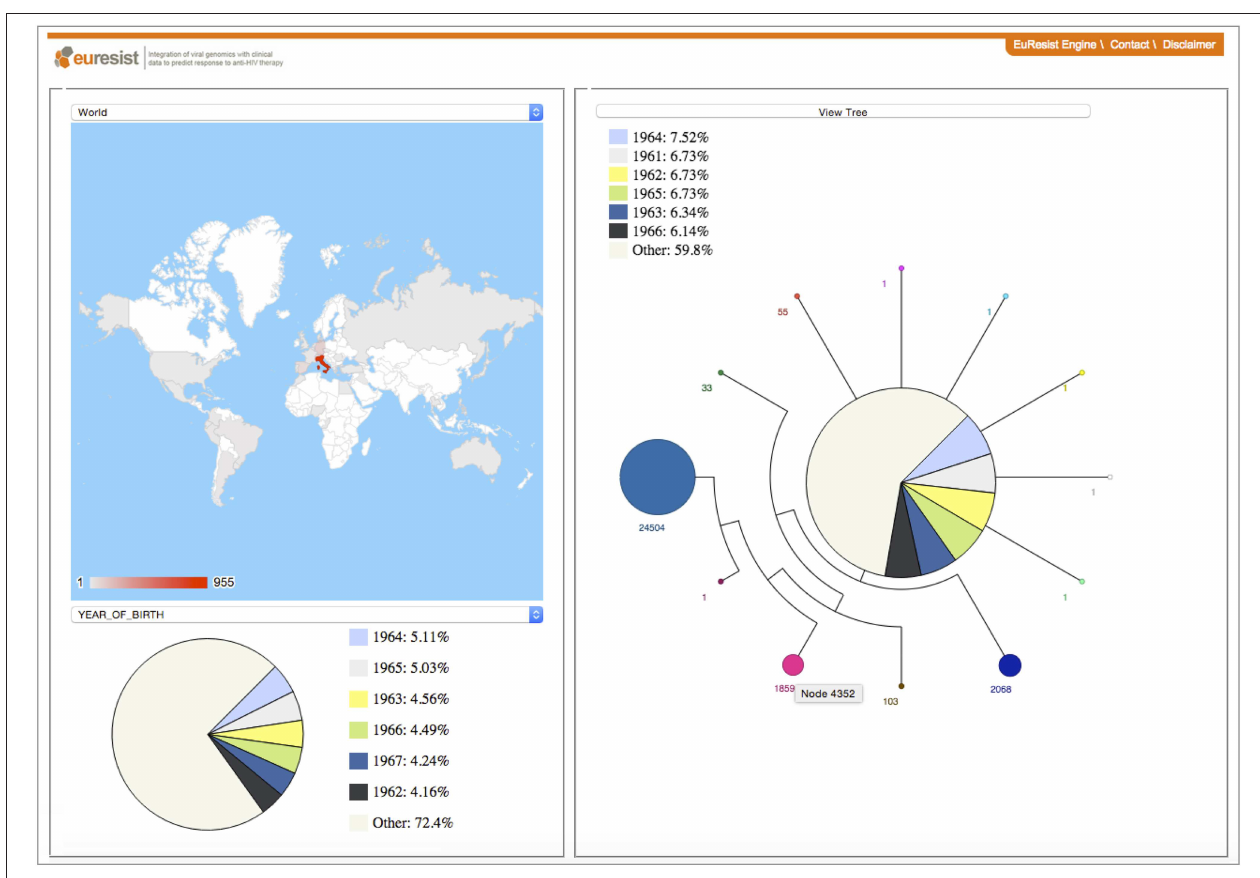
FIGURE 4 | The PhyloGeoTool offers a visual approach to explore large phylogenetic trees and to depict characteristics of strains and clades—including for example the geographic context and distribution of sampling dates—in an interactive way ( 17). A progressive zooming approach is used to ensure an efficient and interactive visual navigation of the entire phylogenetic